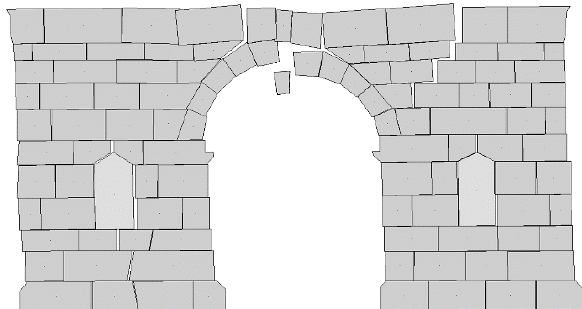
Figure 13. Collapse mechanism and current seismic vulnerability.